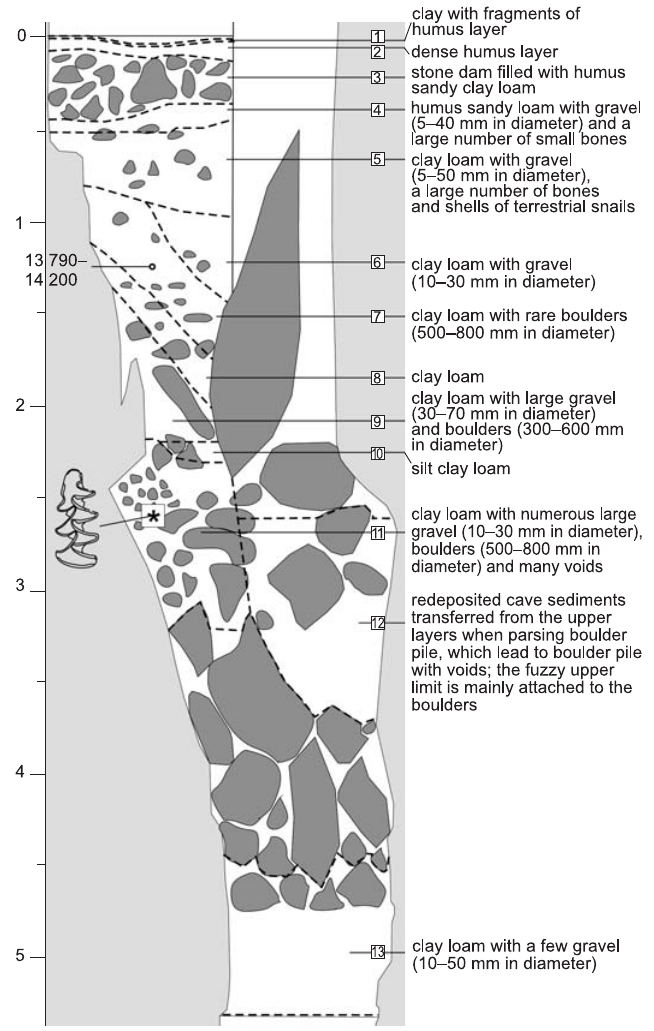
Fig. 2. Diagrammatic picture deposits of the southwestern wall of the ex- cavation pit in the Medvezhyi Klyk Cave. Asterisk indicates the site of Mimomys chandolensis sp.